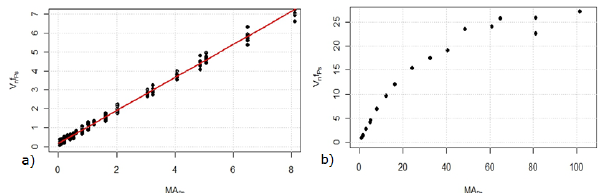
Fig. 5. (a) Relation between mass flux ratio M times A P for R = 11.87. The red line shows the fitted linear model, y = 0.87 x + 0.18 with an explained variance of 0.99. (b) Indication that for larger values of MA P the relation is nonlinear. s